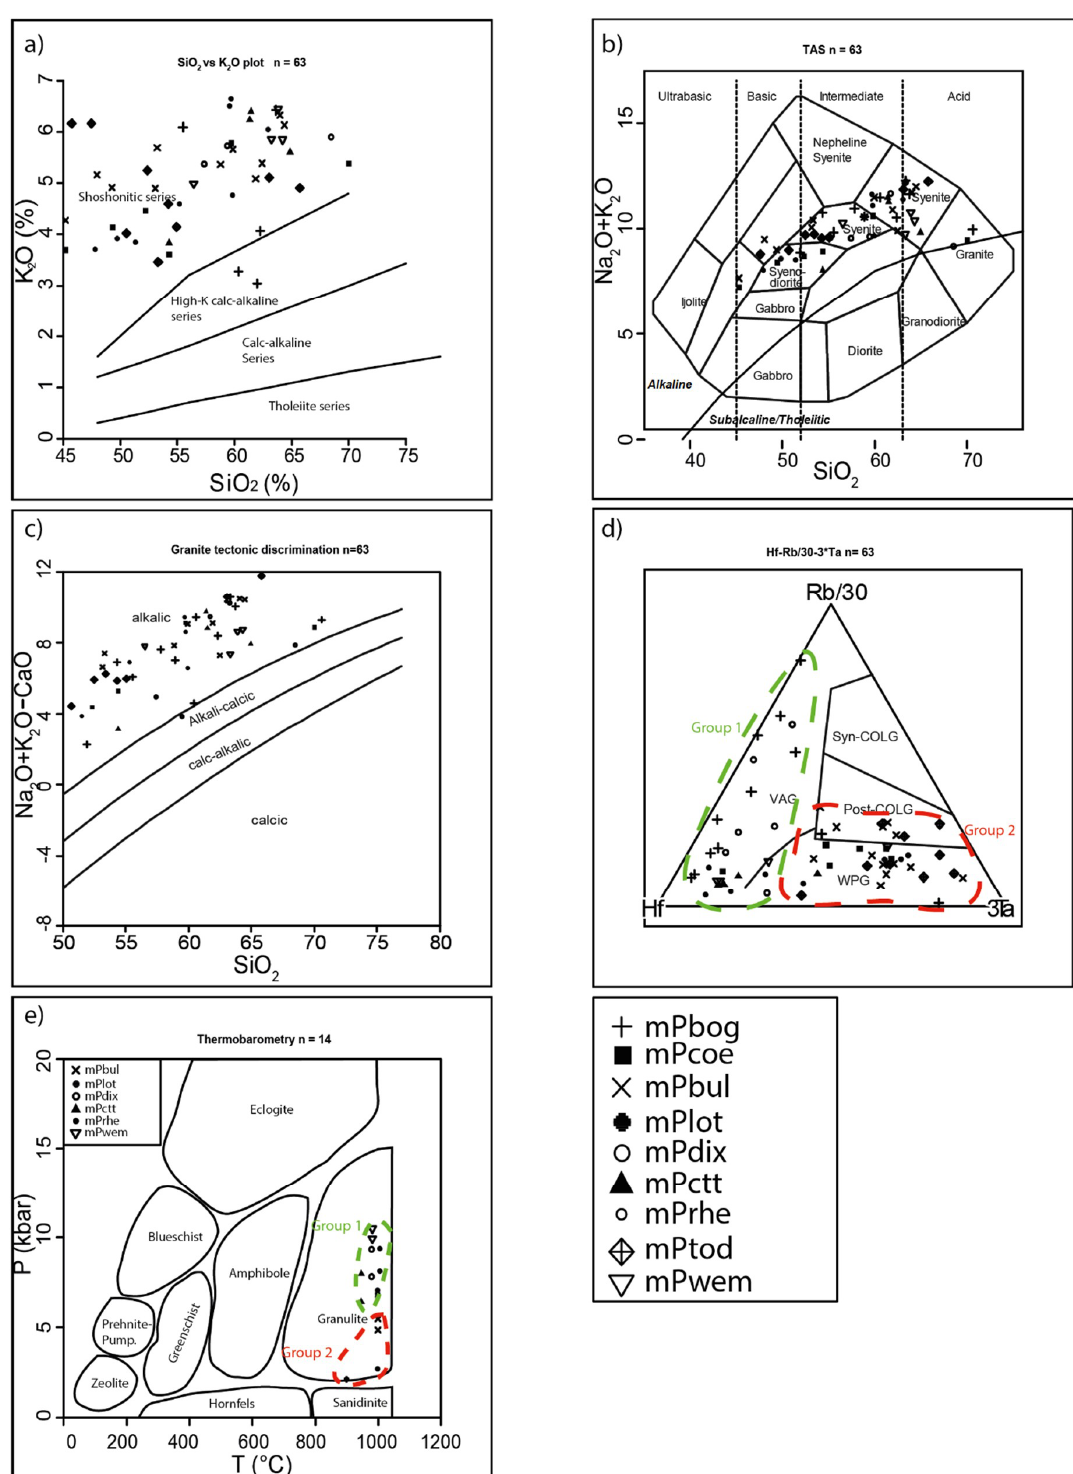
Figure 4. Whole-rock geochemistry of the 63 outcrop samples. ( a ) Affinity SiO 2 vs. K 2 O [21] diagram showing the shoshonitic affinity of the intrusions, ( b ) Total alkali vs. silice diagram [22] showing the composition range of the intrusions varying from syenodiorite to granite, ( c ) Granite tectonic discrimination showing the alkaline affinity [23] of the intrusions, ( d ) Hf vs. Rb/30 vs. 3*Ta [24] showing separation of two groups corresponding to different tectono-magmatic systems, ( e ) thermobarometric results showing the different P-T of the two groups.